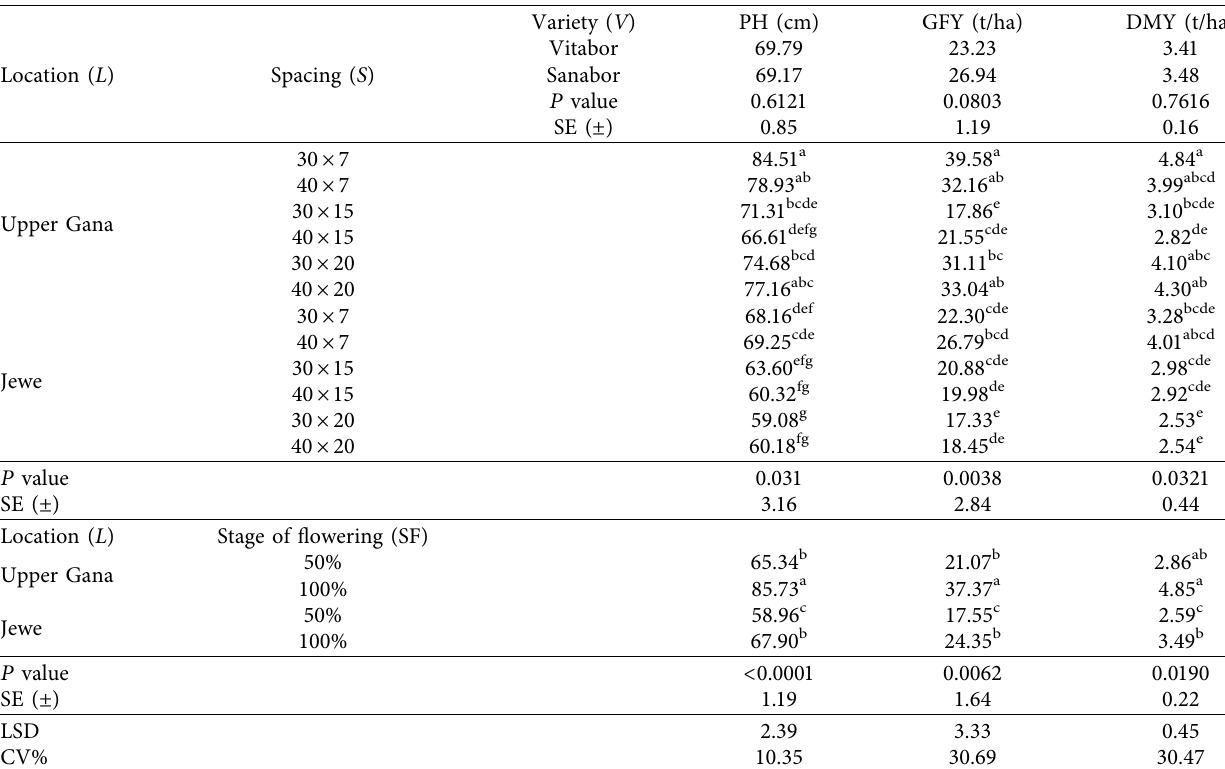
Table 2: Effects of location, spacing, and stage of flowering on plant height (cm), green forage yield (t/ha), and forage dry matter yield (t/ha).